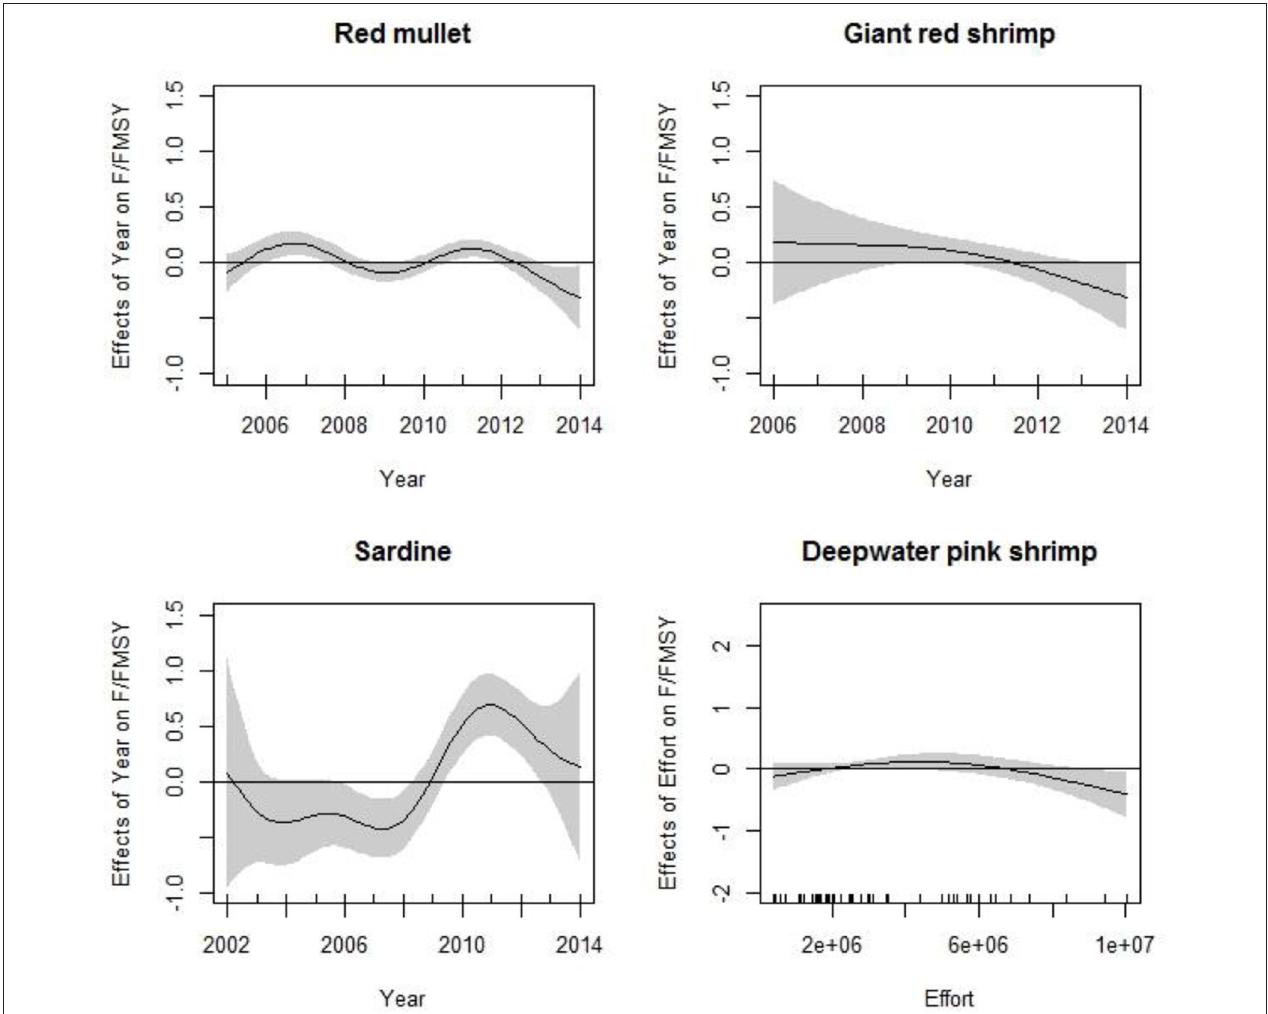
FIGURE 2 | Effect of the predictors (with the 95% confidence intervals) on the ratio between F/F MSY for each model species. Only significant predictors were shown. For model details see Material and